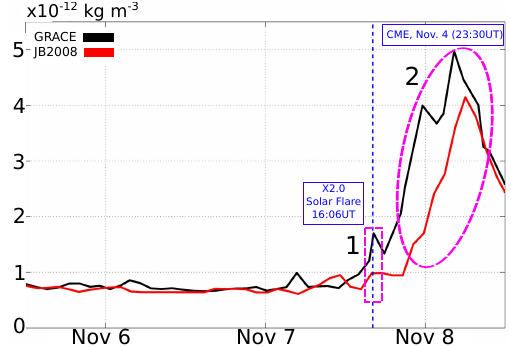
Table 4. Estimates for exobased densities and exosphere tem- peratures from various source, including the algorithm described in Krauss et al. (2012), Tian et al. (2008), Kulikov et al. (2007) and the results from the present study using TIMED/SEE and SOHO/SEM data.